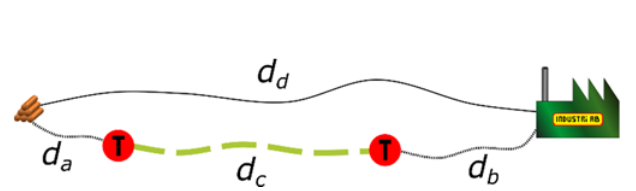
Figure 4. Schematic illustration of transport legs in a direct flow (dd) and a via-corridor multiplex flow (da + dc + db).